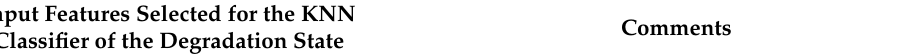
Figure 2. Four-state (left-to-right) model for the degrading bearing. Table 1. Set of selected features for degradation state assessment from Reference [22]; here DrE refers to features extracted from the drive end sensor, FE from the fan end sensor.